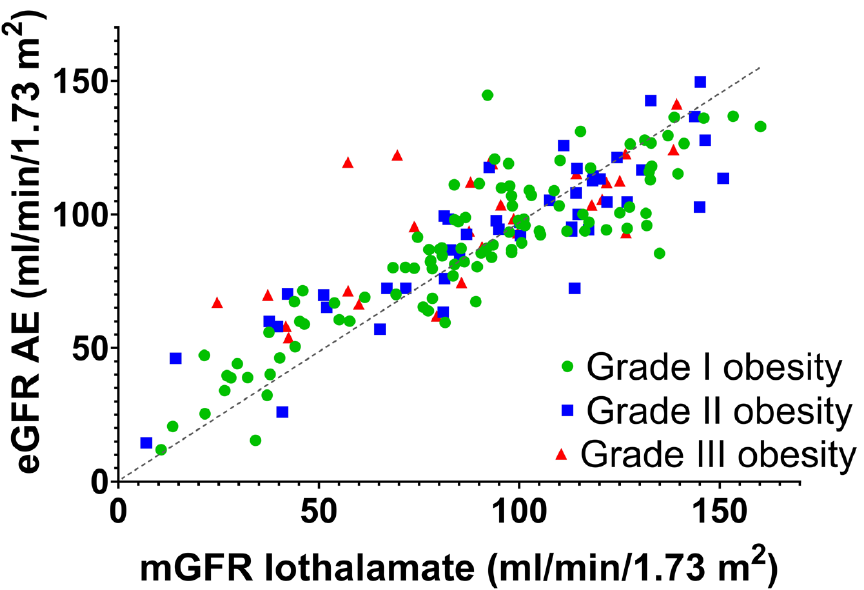
Figure 2. Scatter plot between the eGFR by Argentinian Equation (AE) and the mGFR by urinary clearance of iothalamate in the 3 degrees of obesity in IVS. The reference line is the identity line. Table 4. Performance of the different equations to estimate the mGFR in the TVS ( n = 26).